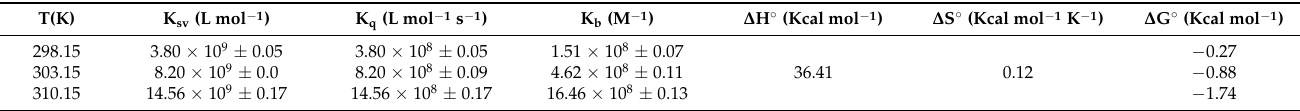
Table 1. Fluorescence quenching and binding parameters of CTZ–HEWL interactions at different temperatures .